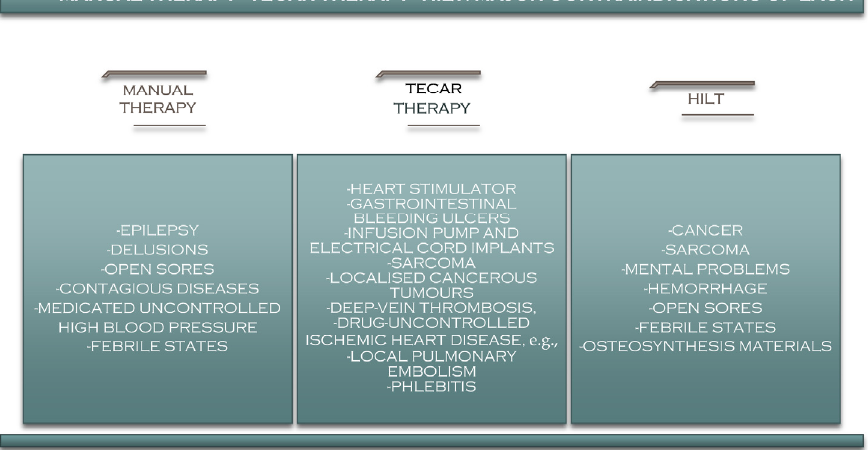
Figure 8. Contraindications of manual therapy, TECAR, and HILT therapy.